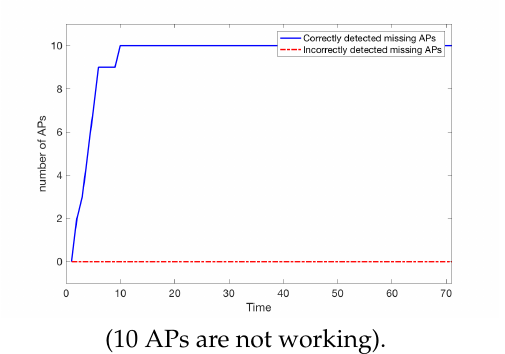
(10 APs are not working). Figure 14. Number of missing APs